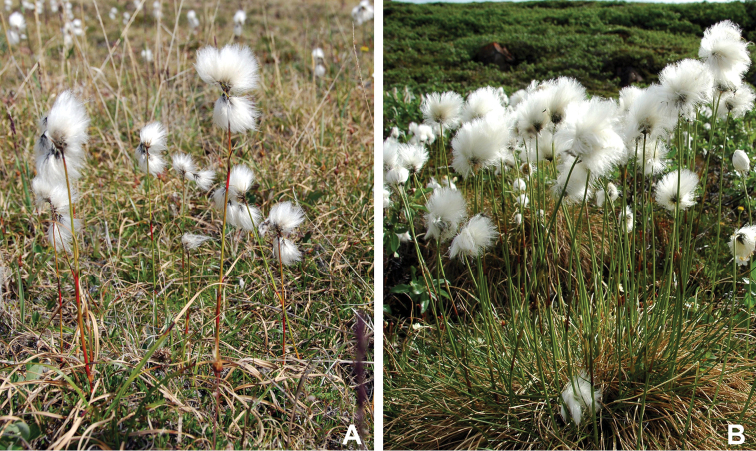
AEriophorum
triste habit BEriophorum
vaginatum
subsp.
vaginatum habit, Gillespie et al. 7948. Photo A by J.M. Saarela and B by R.D. Bull.